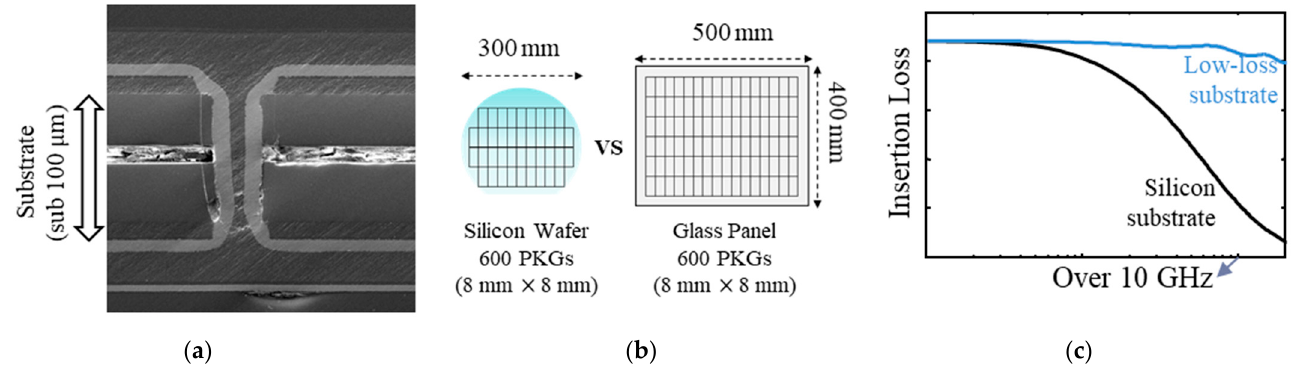
Figure 1. Advantages of low-loss substrate for packages and interposers. ( a ) Ultrathin (sub 100 μ m) and fine-pitch metallization; ( b ) high fabrication yield, which has great potential for cost reduction; ( c ) low signal loss, enabling high-speed signaling.